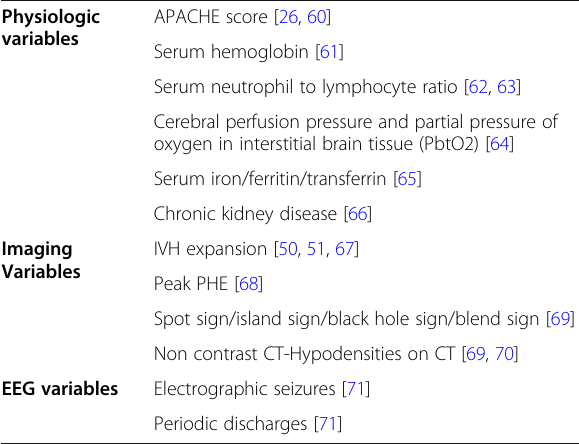
Table 3 Variables reported in the literature to consider for inclusion into future ICH prediction